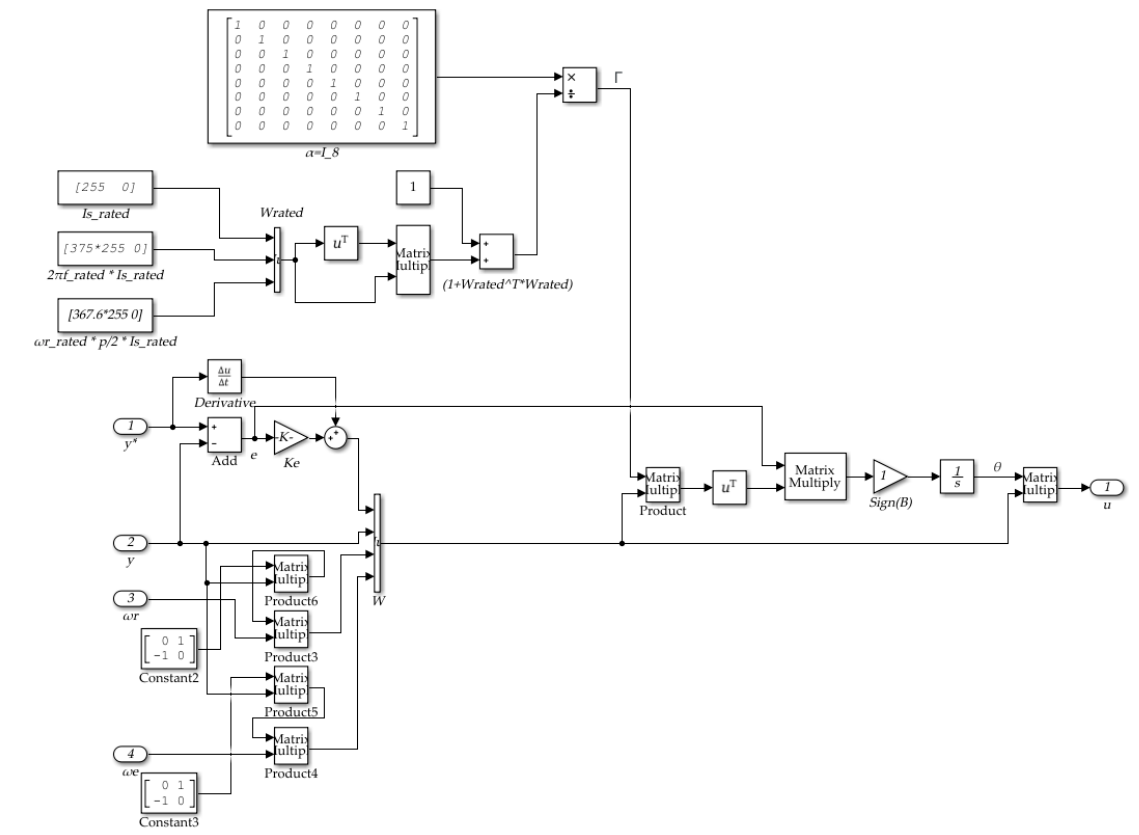
Figure 3. Simulink block diagram of the normalized FG-APBC for the IM.